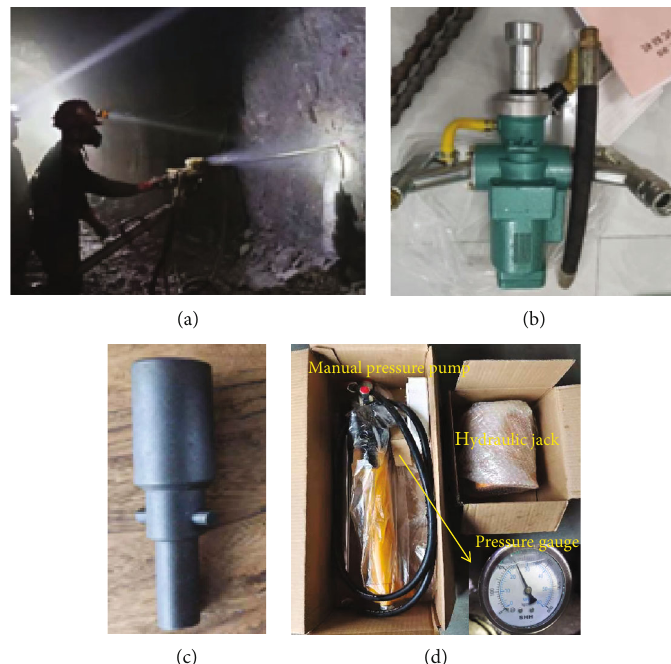
Figure 3: Test equipment. (a) Rock drilling. (b) Air-coal drill. (c) Mixing head. (d) Pulling equipment.